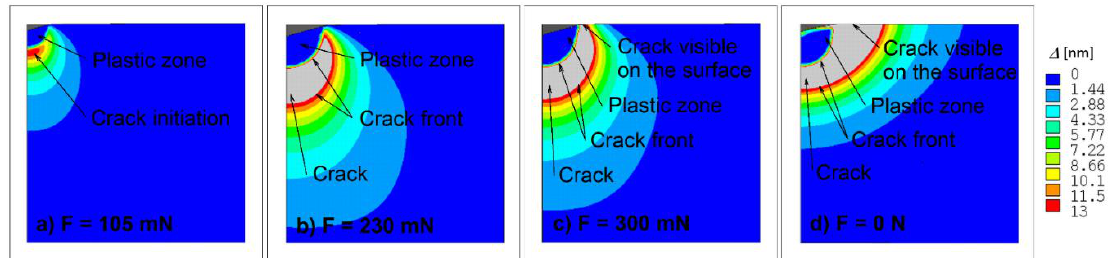
Figure 7. Crack extension during the indentation test for maximal loading force of 300 mN: loading force ( a ) F = 105 mN, ( b ) F = 230 mN, ( c ) F = 300 mN and ( d ) F = 0 N.